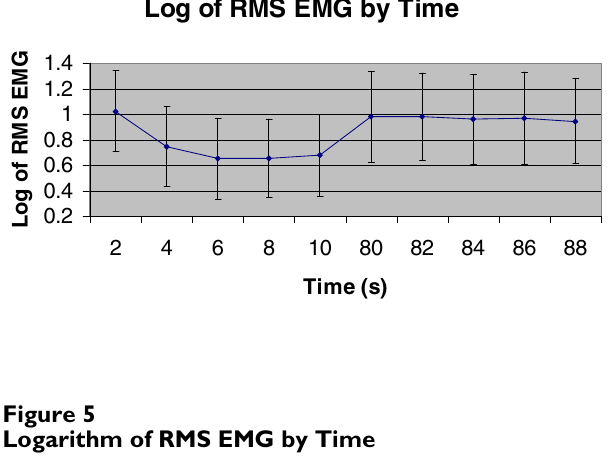
Log of RMS EMG by